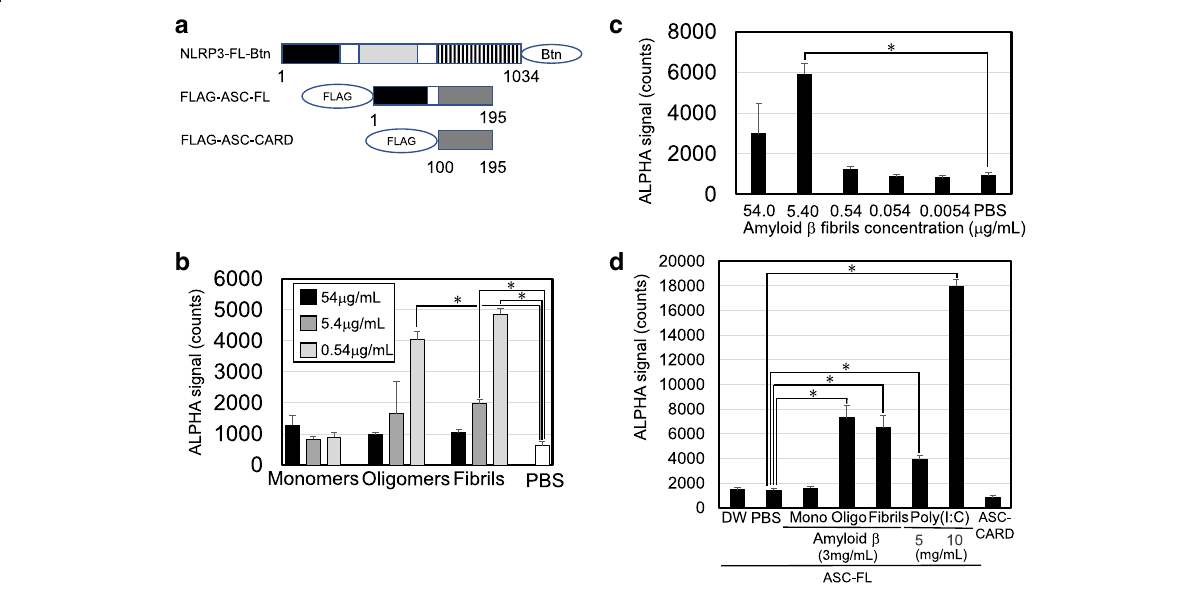
Fig. 2 Direct interaction between A β and NLRP3 induced the initial event of NLRP3 inflammasome activation. a Schematic representations of NLRP3 and ASC. Synthetic C-terminal biotinylated full-length NLRP3 (NLRP3-FL-Btn), N-terminal FLAG-tagged ASC (FLAG-ASC-FL), and N-terminal FLAG-tagged ASC-CARD (FLAG-ASC-CARD) are indicated. The pyrin domain (PYD) is indicated by black boxes. The caspase recruitment domain (CARD) is indicated by a dark gray box. The nucleotide-binding oligomerization domain (NOD) is indicated by a light gray box. Leucine-rich repeats are indicated by a striped box. Amino acid sequence numbers are indicated under each schematic. b Interaction between NLRP3-FL-Btn and each form of A β with indicated concentrations is presented. c Interaction between NLRP3-FL-Btn and A β fibrils with indicated concentrations is presented. d Interaction between NLRP3-FL-Btn and FLAG-ASC-FL upon incubation with each form of A β with indicated concentrations. Interactions between NLRP3-FL-Btn and FLAG-ASC-FL upon incubation with poly(I:C) were positive controls. Interaction between NLRP3-FL-Btn and FLAG-ASC-CARD was the negative control. Interaction was detected by an amplified luminescent proximity homogeneous assay (ALPHA). Results are given as means± standard deviation of triplicate data acquisition. * p value < 0.05 was considered